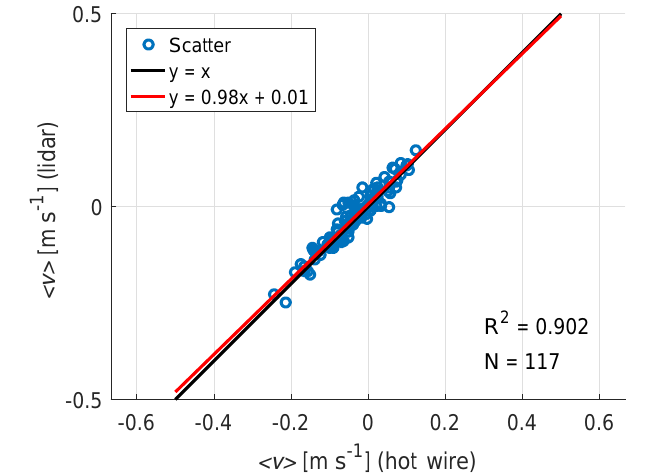
Figure 17. Correlation of the 1Hz averaged v component.